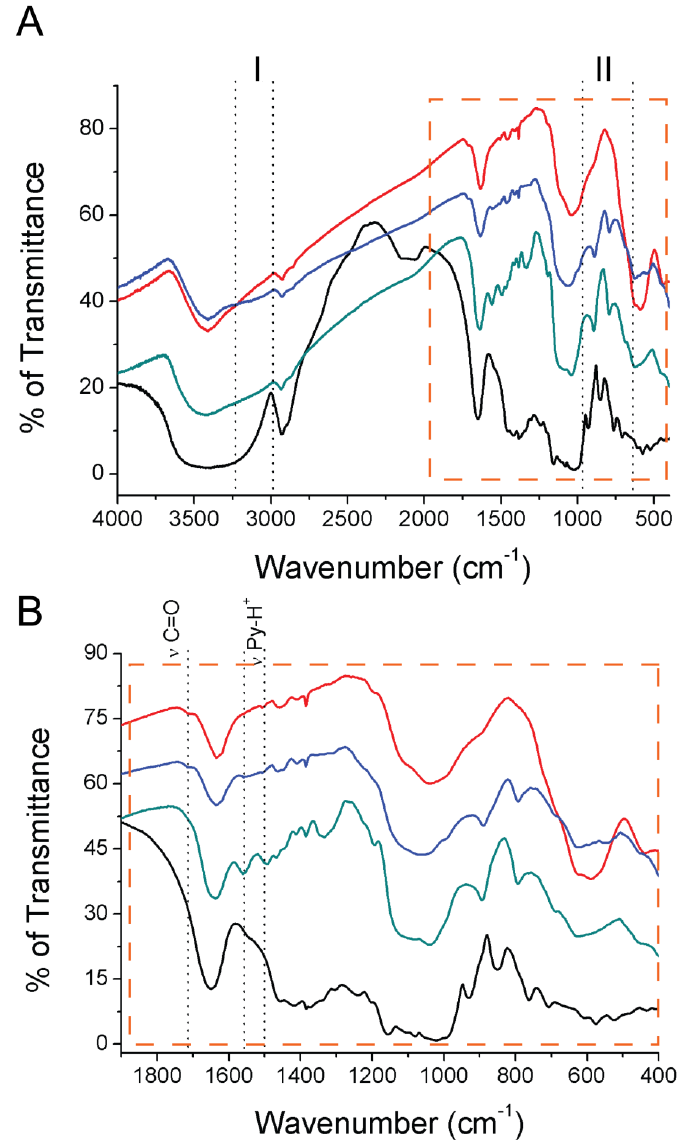
Figure 3. Infrared spectra of free CAL-B (black line), NP-ImS 4 /CAL-B (red line), NP-ImS 10 /CAL-B (blue line), NP-ImS 18 /CAL-B (green line). ( A ) Region from 4000 cm −1 to 400 cm −1 and ( B) region from 1850 cm −1 to 400 cm −1 .